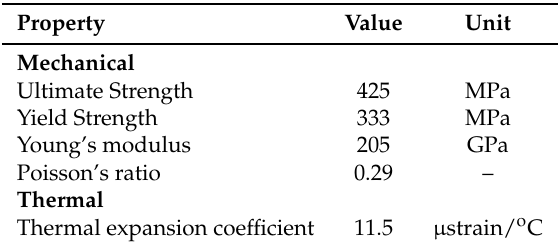
Table 1. Characteristics of steel St 37-2 according to standard EN 10025-2: 2004, grade S235JR. Property Value Unit